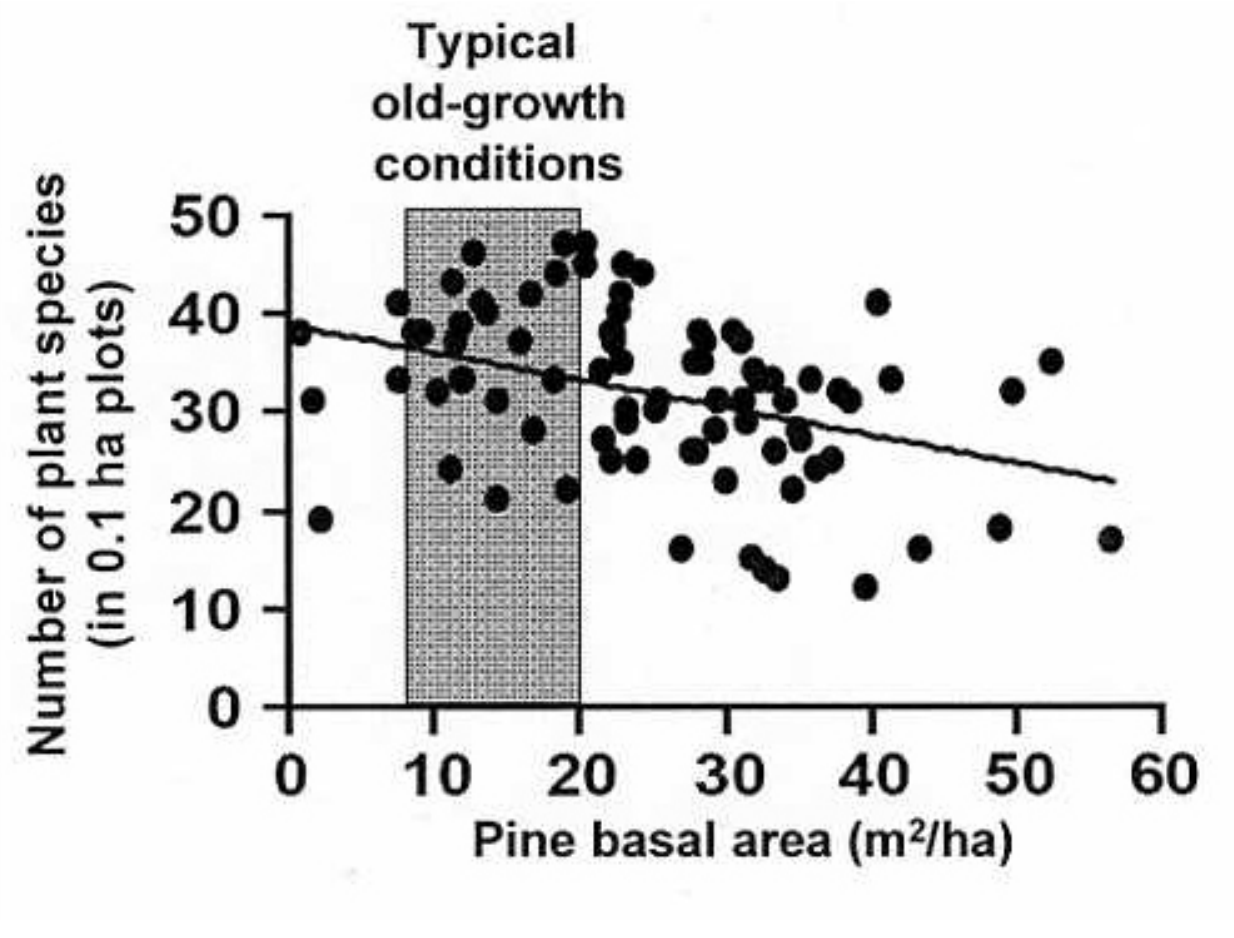
Fig. 2. The richness of understory plant species declines with increasing density of overstory pine trees, on the Kaibab Plateau in northern Arizona (after Laughlin and Grace 2006). Typical historic conditions would have had about 35 species per 0.1-ha plot, but with changing land use and fire regimes, the most common species richness has declined to 25 to 30 species per 0.1-ha